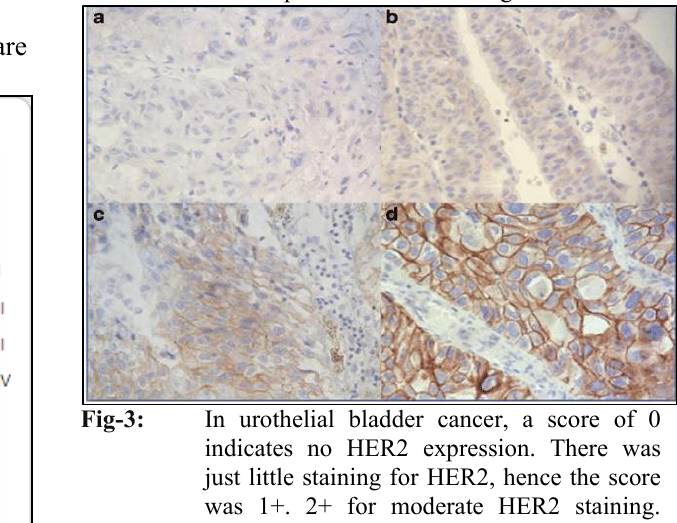
In urothelial bladder cancer, a score of 0 indicates no HER2 expression. There was just little staining for HER2, hence the score was 1+. 2+ for moderate HER2